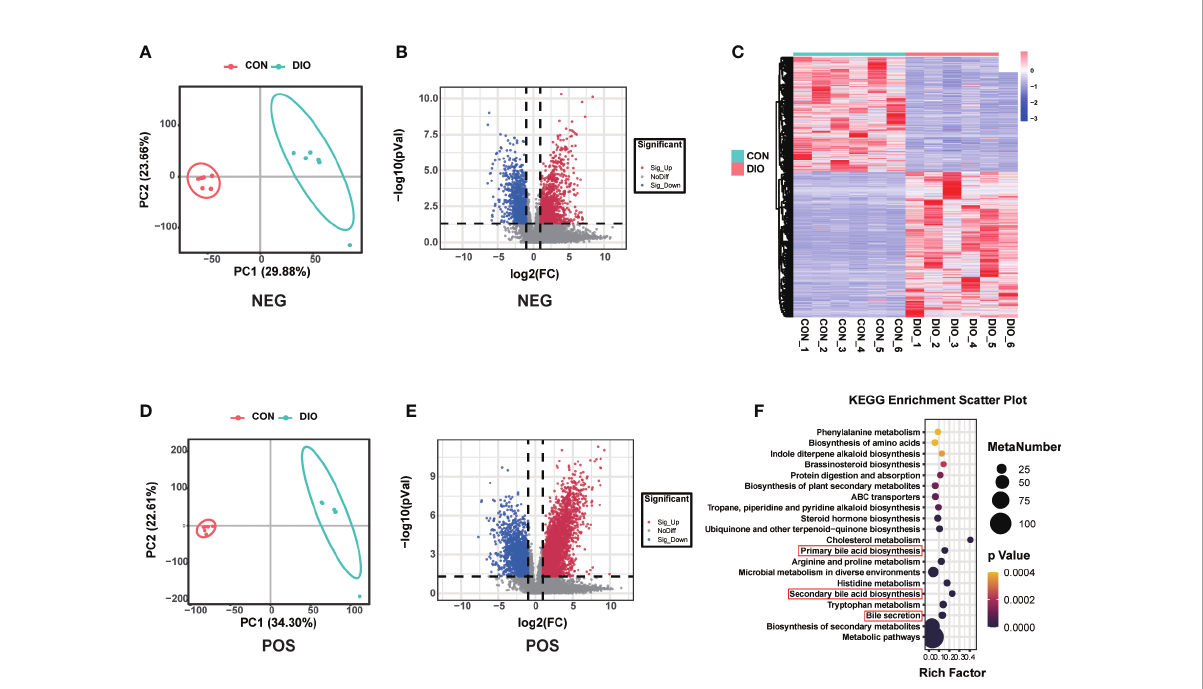
FIGURE 5 DIO markedly alters the fecal metabolome. (A, B) PLS-DA analysis of fecal metabolites between the two groups; variable importance in projection (VIP) > 1, R2 > 0.5, Q2 > 0.5. (C, D) Volcano maps displaying differential fecal metabolites. (E) Heat map of fecal metabolites in the two groups. (F) Bubble diagram of the top 20 enriched KEGG